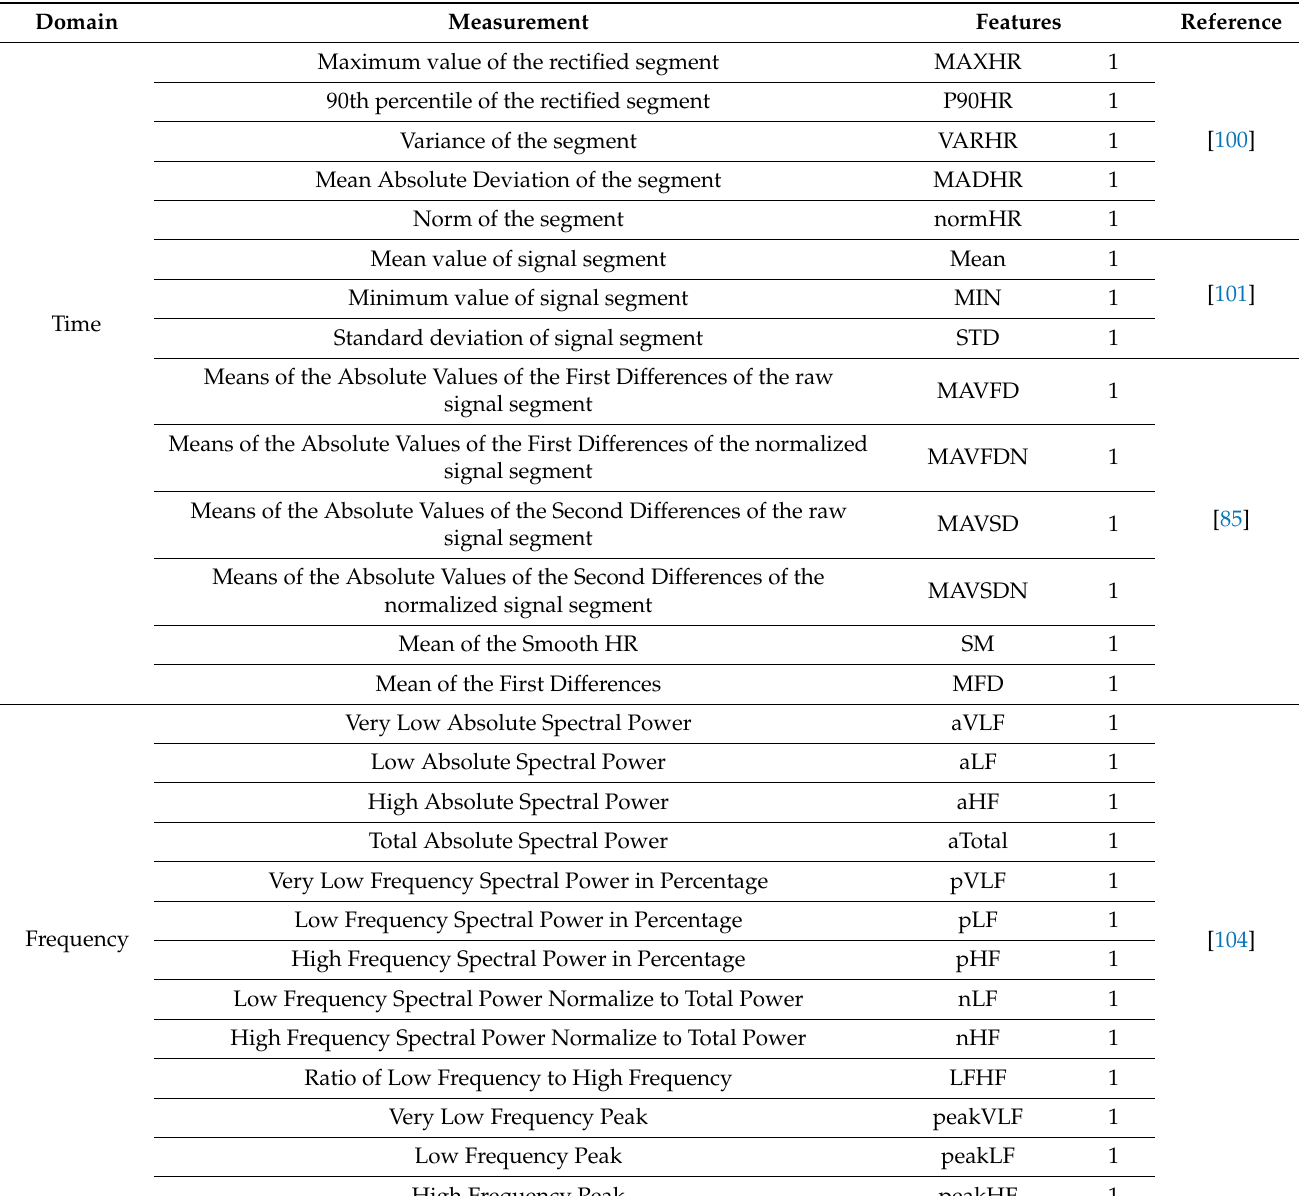
Table 9. Heart rate